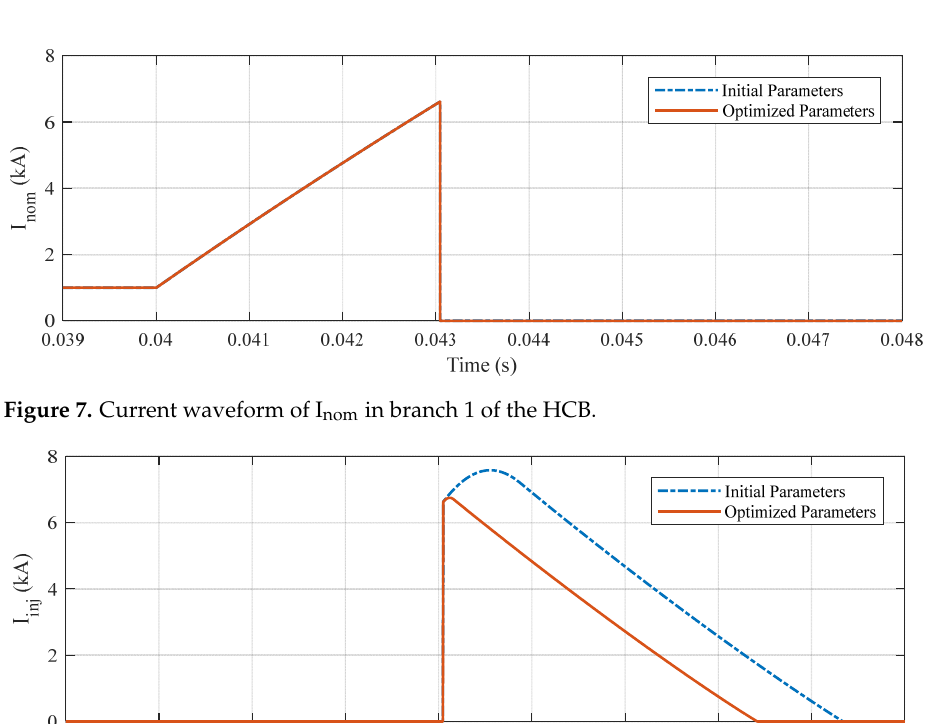
Figure 6. Current waveform of I (cid:2913)(cid:2912) of the HCB